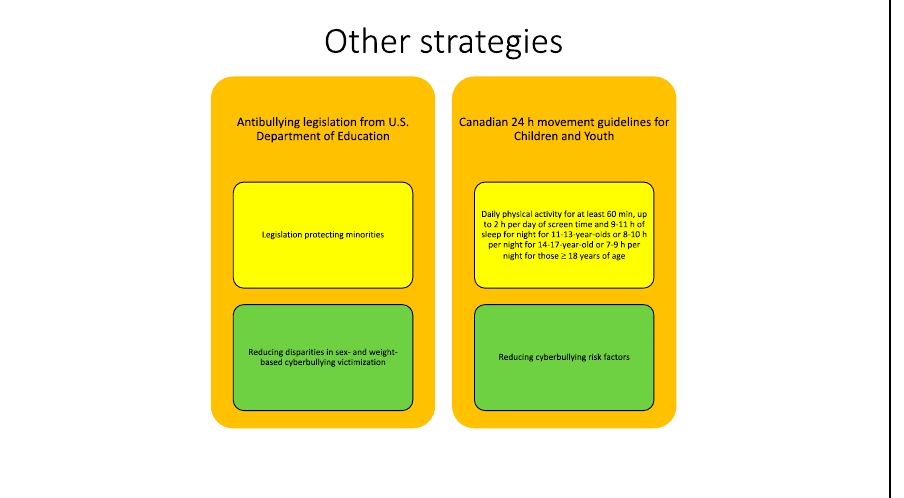
Figure 6. This figure summarizes descriptions and objectives of the other strategies that will be presented below. The name of the strategy is reported in orange boxes. Yellow boxes contain different strategies’ descriptions, while objectives are stated in the green boxes.